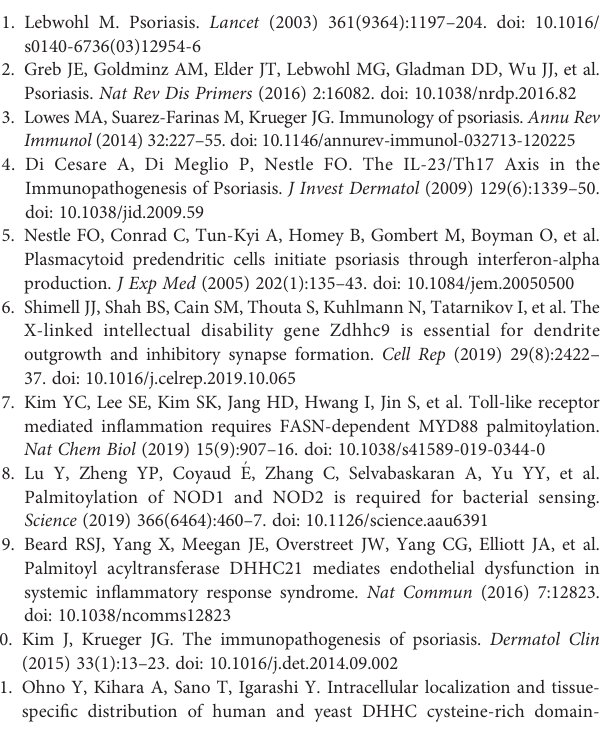
remaining cells were gated for CD11b - Siglec H + CD317 + as pDCs. (D) pDC gating strategy in the blood. After excluding dead cells (DAPI positive), T cells (CD5 + ), B cells (CD19 + ), and monocytes (CD115 + ), the remaining cells were gated for CD11b - Siglec H + CD317 + as pDCs. The expression of pDC activation marker CD80 was displayed by histogram. SUPPLEMENTARY FIGURE 3 | Detection the effect of zDHHC2 knockout on T cell in fi ltration in in fl amed skin by using transfer experiment. (A) CD45.2 T cells gating strategy in the skin. After excluding dead cells (DAPI positive), B cells (CD19 + ), neutrophil (Ly6G+), dendritic cells, and macrophages (MHC II + ), the remaining cells were gated for CD45 + CD5 + as T cells or CD45 + TCR b + as ab T cells, thenT cellsand ab Tcells weregatedfor CD45.1 − CD45.2 + asCD45.2 Tcells and CD45.2 ab T cells. (B, C) Comparison the absolute cell number and CD44 MFI of CD45.2 + T cells and CD45.2 + ab T cells in the psoriatic skin of CD45.1 + CD3 ϵ − / − which respectively transferred with CD45.2 + T cells from WT and Zdhhc2 − / − mice. Experiments were repeated twice, involving three mice for each time point per genotype (mean ± SEM). ns, not signi fi cant. SUPPLEMENTARY FIGURE 4 | Detection of TLR7 protein level, intracellular distribution, and p65 phosphorylation level in WT and zDHHC2 − / − CAL-1 cells. (A) DNA sequencing analysis showed the presence of the intended zDHHC2 − / − cell lines. The deletion size is indicated below the WT sequence. Red letters correspond to the PAM sequences and blue letters to the sgRNA sequences. (B) MFI of TLR7 expression in CAL-1 WT and CAL-1 zDHHC2 − / − cells after stimulating by gardiquimod for indicated time points (n = 3, mean ± SEM). (C) Western blot analysis for TLR7 in CAL-1 WT and CAL-1 zDHHC2 − / − cells after stimulating by gardiquimod. (D) Immuno fl uorescence of CAL-1 WT and CAL-1 zDHHC2 − / − cells after 0 or 24 h gardiquimod stimulation. Scale bar = 5 m m. (E) MFI of p65 phosphorylation in zCAL-1 WT and CAL-1 zDHHC2 − / − cells after stimulating by gardiquimod for indicated time points (n = 3, mean ± SEM). (F) Western blot analysis for phospho-p65 in CAL-1 WT and CAL-1 zDHHC2 − / − cells after stimulating by gardiquimod. ns, not signi fi